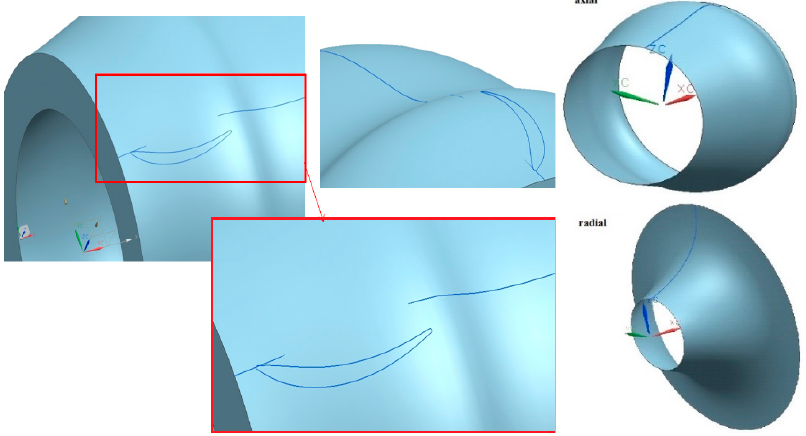
Figure 7. Mapping of the 3D airfoil on the corresponding stream surface (axial and radial).